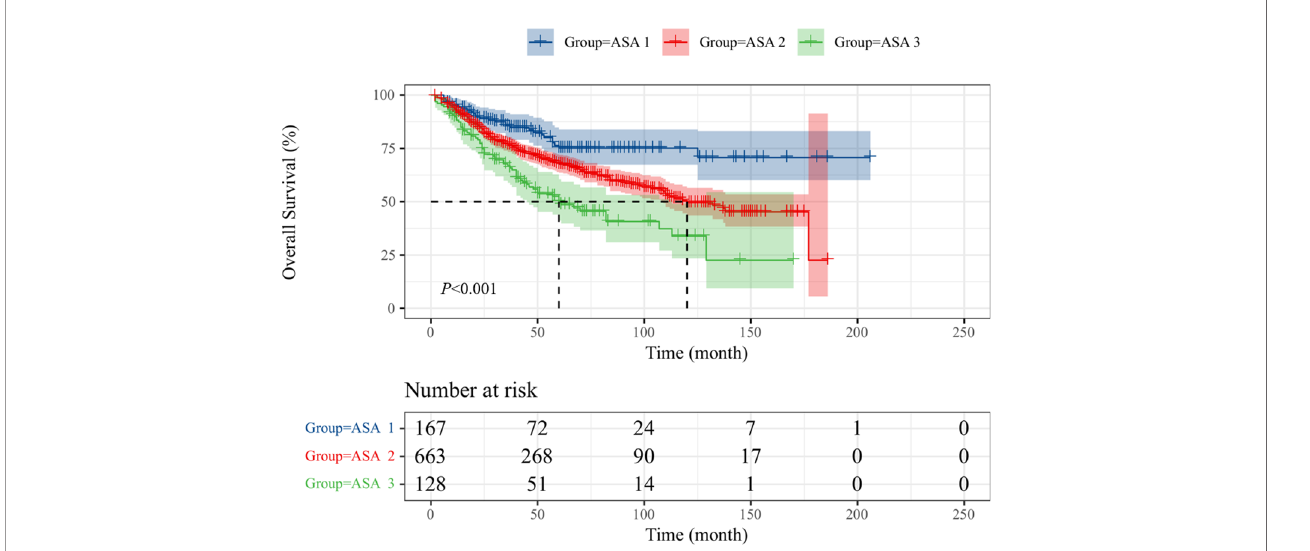
FIGURE 1 | Kaplan-Meier curves for OS strati fi ed according to ASA scores.